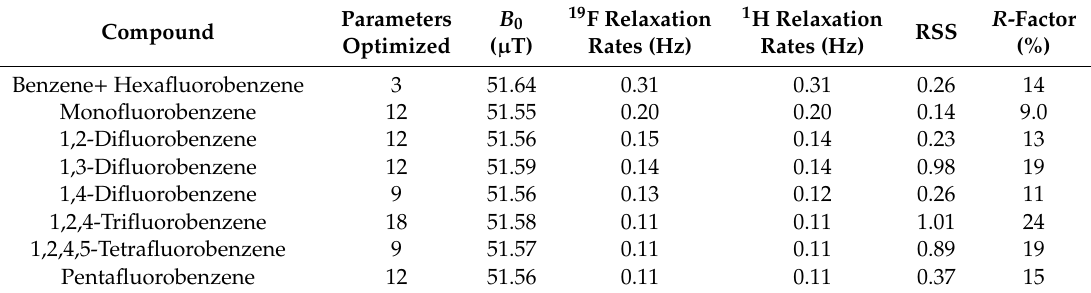
Figure 2. Instrument response of the tuned circuit used for detection of the fluorobenzene compounds without a sample. The blue dotted line corresponds to the center frequency of the 1 H nucleus, while the red dotted line denotes the 19 F response. The 19 F resonances are preferentially enhanced, relative to 1 H by a factor of 1.52. The 60 Hz overtone noise spikes were omitted for clarity. Table 1. The number of optimized parameters for the simulation and resultant B 0 , 19 F, and 1 H relaxation rates; residual sum of squares (RSS); and R -factor of the best fit for each fluorobenzene compound’s J -coupled spectra (JCS).